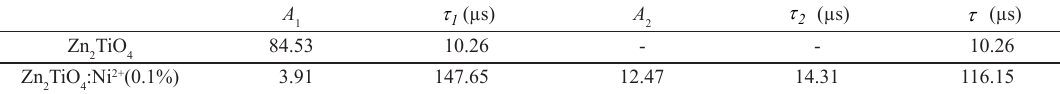
TiO and Zn TiO :Ni 2+ 2 4 2 4